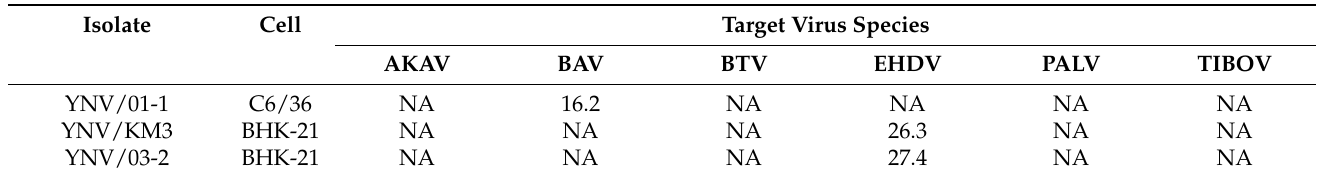
Table 1. Quantification cycle (Cq) values of RT-qPCR tests of three viruses isolated from Culicoides spp. in Yunnan Province, China.